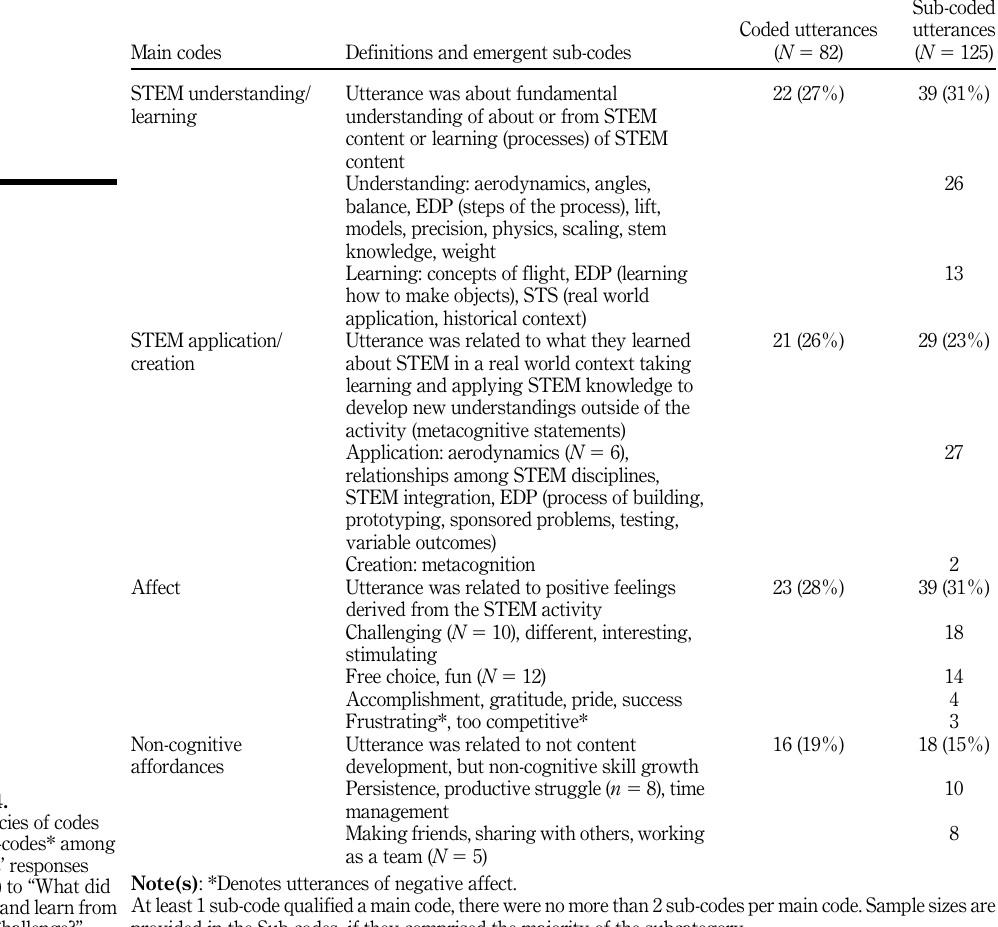
Table 5 (interactions with mentor/s) was open coded by increasing levels of interactions (passive to active) as well as evidence of positive affect and providing encouragement. The vast majority of students reported passive interactions ( n 5 17, 36%), followed by indicating their mentor was generally helpful ( n 5 13, 28%) to them or their group. Ten codes (21%) pertained to positive affect students reported in their interactions, whereas only six utterances (13%) related to having active engagement with the undergraduate mentor. Table 6 categorizes students ’ responses, coded to the 4Cs constructs and sub-constructs (NEA, 2012) in how they interacted with their group during the STEM Challenge. The greatest amount of responses related to collaboration ( n 5 23, 35%) and creativity ( n 5 22, 34%), where students remarked working as a team ( n 5 10, 43% of collaboration construct)